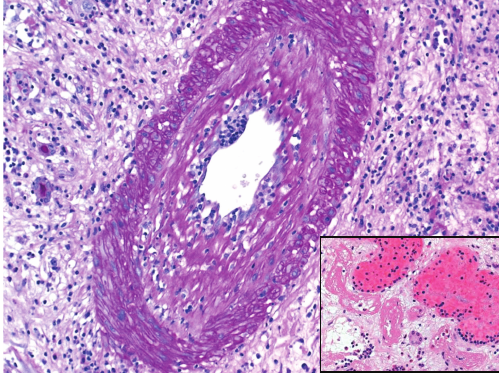
Figure 4: Severe endarteritis was readily identified in the interstitial blood vessels (PAS stain × 200), along with arterial and arteriolar fibrinoid necrosis (Inset H&E × 200).